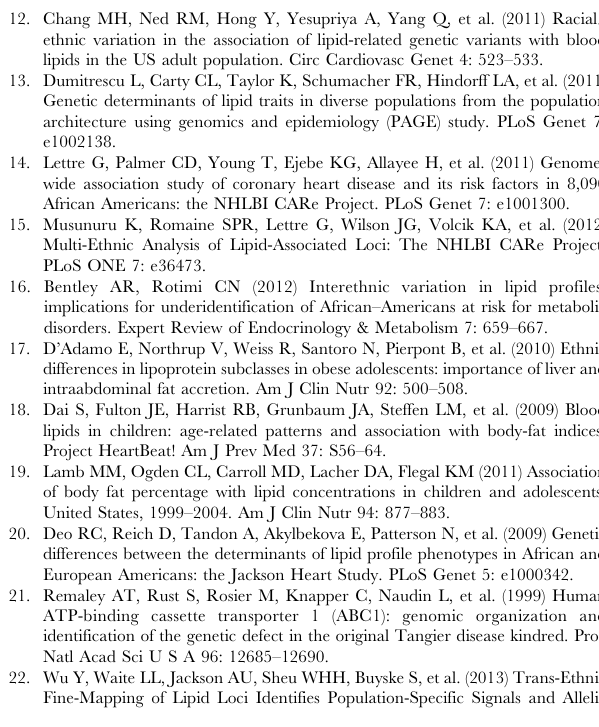
Table S1 Participant characteristics, Africa America Diabetes Mellitus Study. Characteristics of West African participants from the Africa America Diabetes Mellitus Study evaluated for replication. Table S2 Variants found exclusively in one of the sequencing extremes. Variants that were exclusively found in either the Favorable or Unfavorable Lipid Group during the Sequencing Stage.